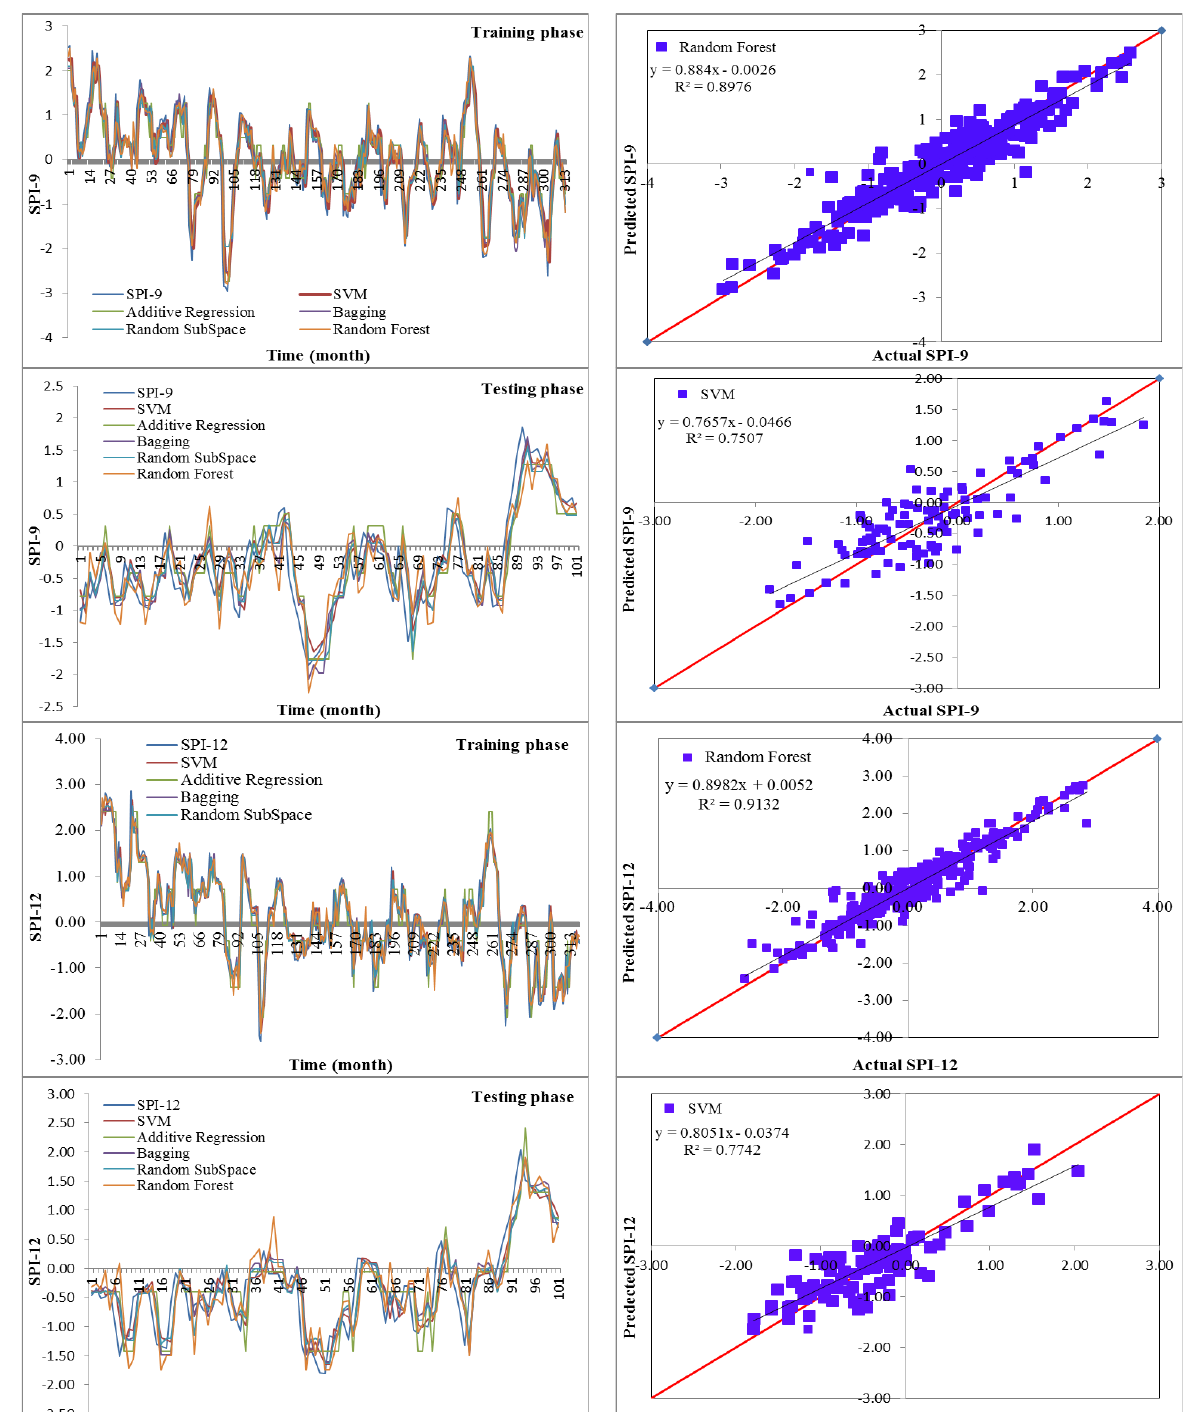
Figure 7. Plots showing predicted and observed SPI values for 3, 6, 9, and 12 timeframes during training and testing periods at sub-basin